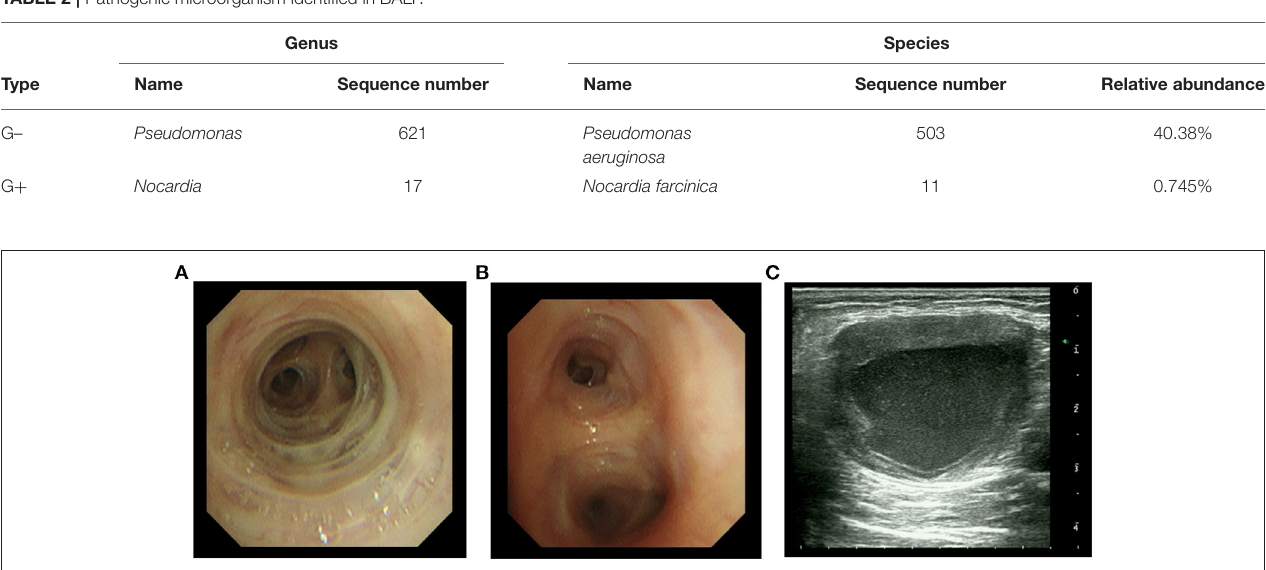
TABLE 2 | Pathogenic microorganism identified in BALF.